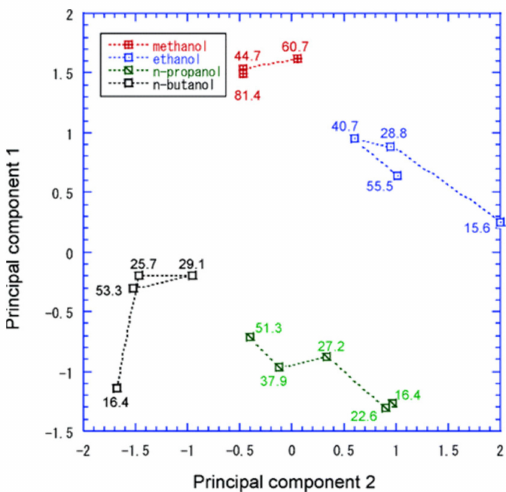
Figure 4. Principal component analysis (PCA) scores plot obtained with sensor array responses resulting from exposure to different vapors. Numbers indicate the concentration of each alcohol in ppmv unit. Figure is reproduced from [74].